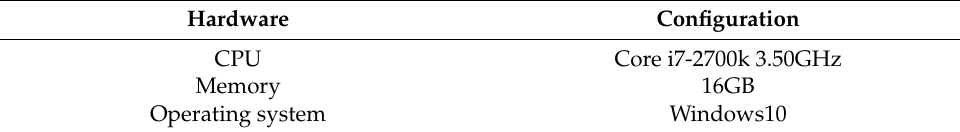
Table 1. Hardware information.